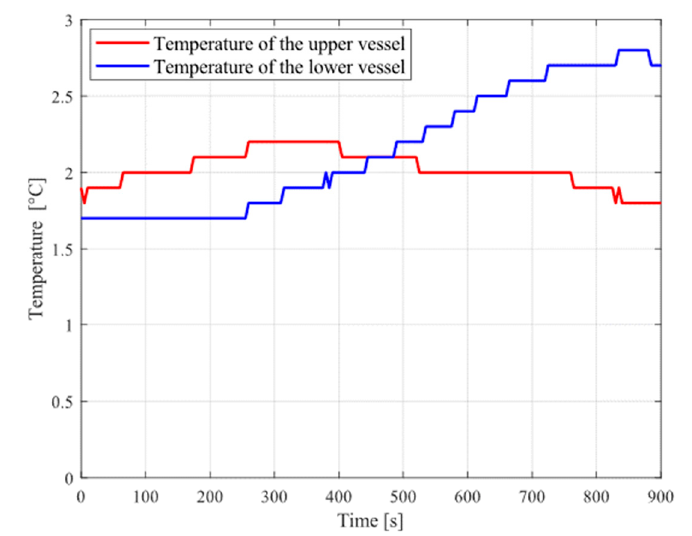
Figure 6. Temperature profiles.